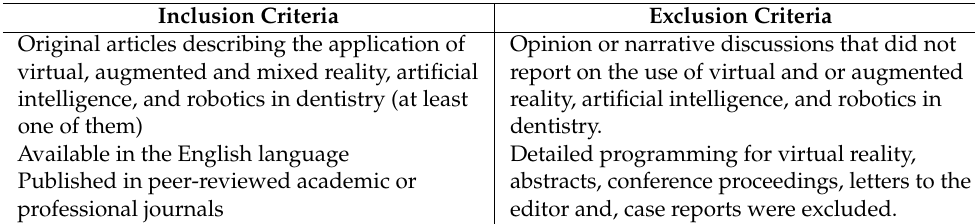
Table 1. List of inclusion and exclusion